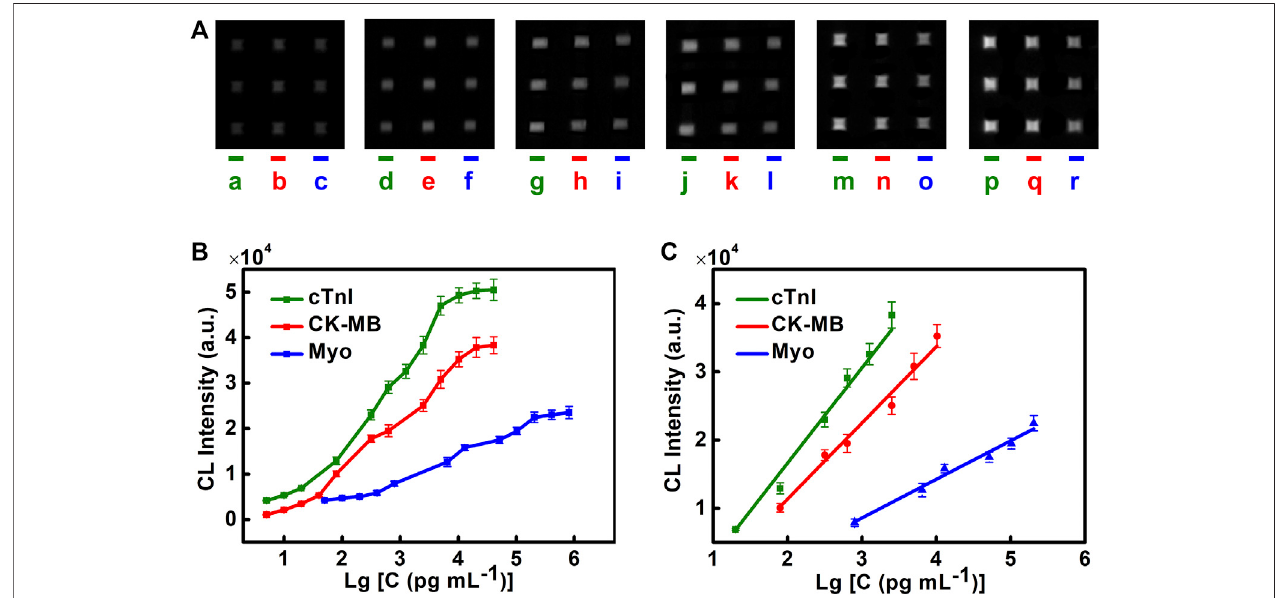
FIGURE 4 | Performance of the micro fl uidic chemiluminescence immunoassay for simultaneous detection of cTnI, CK-MB, and Myo. (A) CL images of cTnI (left) , CK-MB (middle) , and Myo (right) in each chip at different concentrations. The concentrations of cTnI from left to right are 20, 80, 320, 640, 1,280, and 2,560 pg/ml (linesa,d,g,j,m,and p).TheconcentrationsofCK-MBfrom left to right are0.08,0.32,0.64,2.56,5.12,and10.24 ng/ml(linesb,e,h,k,n,andq).Theconcentrations ofMyofrom left to right are0.8,6.4,12.8,51.2,102.4,and204.8 ng/ml(linesc,f,i,l,o,andr). (B) DetectioncurvesofcTnI,CK-MB,andMyo. (C) Linearrangefor cTnI, CK-MB, and Myo. The error bar indicates the standard deviation of the CL signals from nine spots in one micro fl uidic chip.